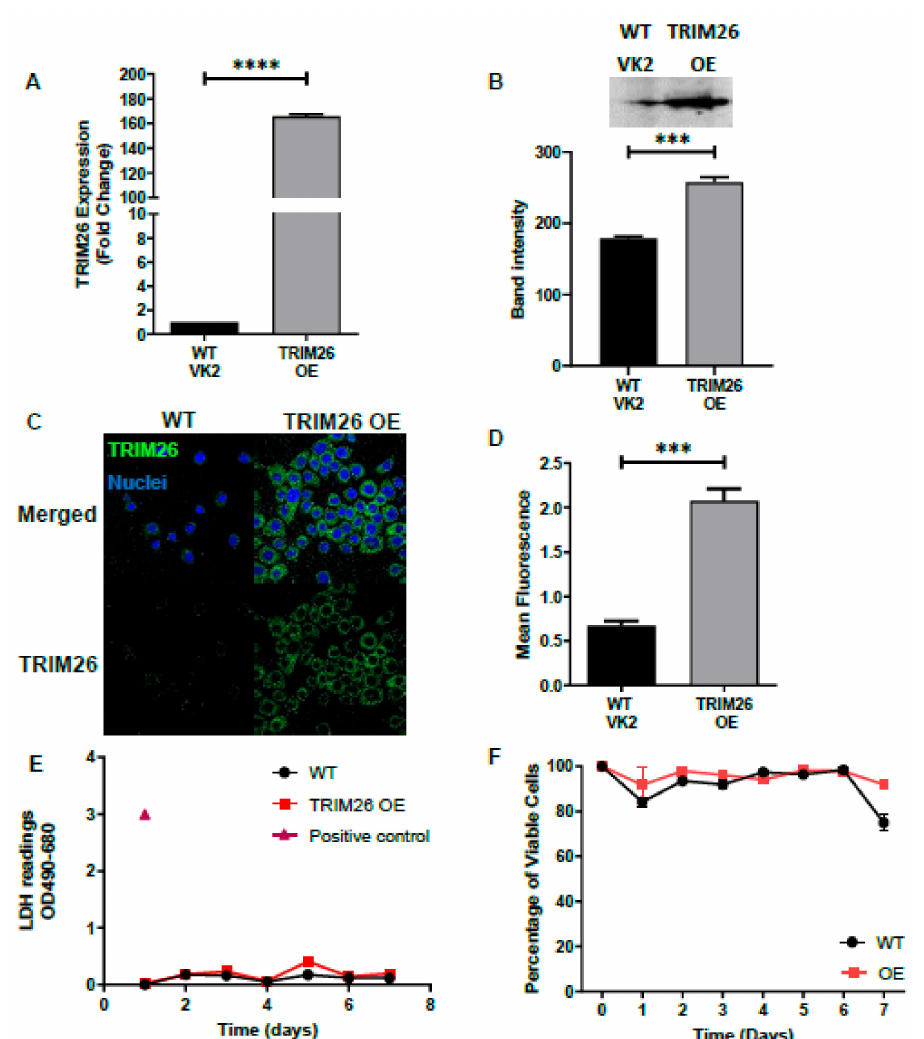
Figure 2. Validation of TRIM26 over expression (OE) cell line. TRIM26 OE cell line was validated by comparison to wild type (WT)VK2 cell line for TRIM26 mRNA and protein expression levels. ( A ) TRIM26 gene expression in WT VK2 and TRIM26 OE cell lines were analyzed by RT qPCR as fold change relative to uninfected WT controls. Results show mean ± SEM fold change ( n = 4); Statistical significance: **** p < 0.0001. ( B ) TRIM26 protein expression analyzed in WT and TRIM26 OE cell lysates by Western blot. Band intensity was measured by ImageJ software for n = 3 samples; statistical significance: *** p < 0.001 ( C ) Representative fluorescent images ( n = 5) with immunofluorescence staining of TRIM26 (green) and nuclear DNA stain (blue) for WT VK2 and TRIM26 OE, by confocal microscopy. Magnification x630. ( D ) Fluorescence of TRIM26 protein from immunofluorescent images was measured by Image J software and mean + SEM calculated ( n = 5). Statistical significance: *** p < 0.001. Supernatant collected from cell lines was used for lactate dehydrogenase (LDH) assay ( E ) and to quantify percent viable cells by Trypan blue dye exclusion test ( F ) comparing WT VK2 with TRIM26 OE cells during 7 days of culture. Positive control total cell LDH shown in ( E ). Data are mean ± SEM for ( n = 3) replicate cultures for both ( E ) and ( F